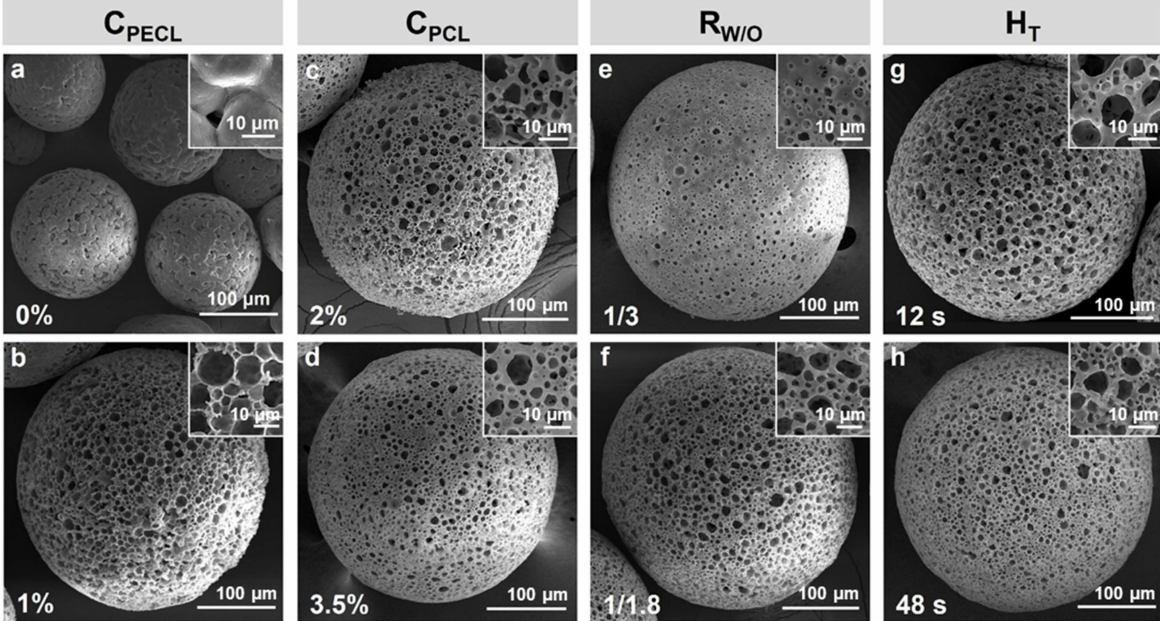
Figure 4. Microspheres prepared with different parameters. ( a , b ) with C PECL of 0% and 1%; ( c , d ) with C PCL of 2% and 3.5%; ( e , f ) with R W/O of 1/3 and 1/1.8; ( g , h ) with H T of 12 s and 48 s. C PECL (PECL concentration, w / w ), C PCL (PCL concentration, w / w ), R W/O (mass ratio of W to O), and T H (homogenization